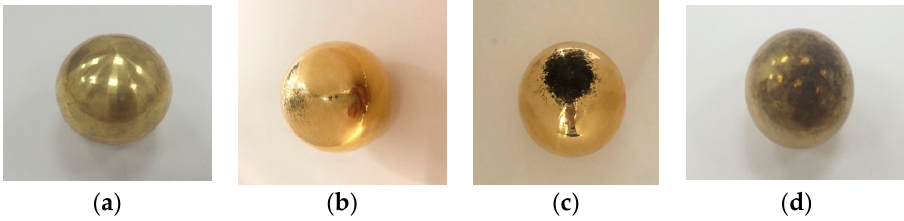
Figure 3. The spherical electrode before and after breakdown of c-C 4 F 8 /N 2 gas. ( a ) the ball electrode